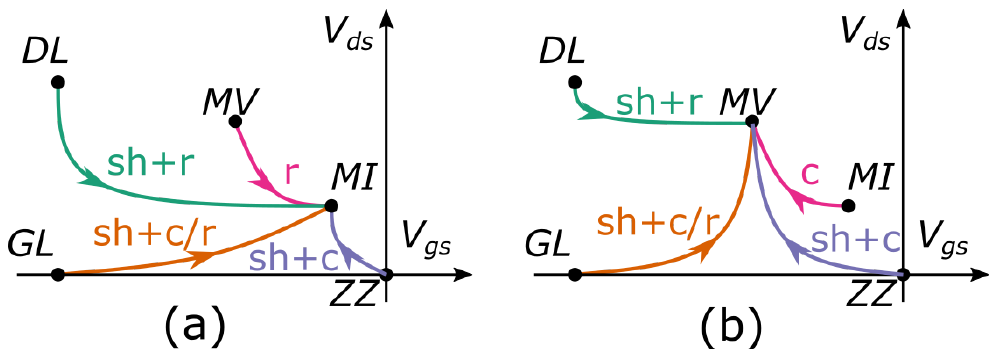
Figure 7. Graphical representation depicting all the relevant trapping/de-trapping transitions on the V GS − V DS plane from the ZZ , GL , DL points to the MI ( a ) and MV points ( b ). The involved processes are highlighted on the transitions: self-heating ( sh ), charge capture ( c ), and release ( r ). Each transition displays a different combination of capture/release and thermal tran- sients, which is often overlooked in typical gate/drain-lag characterizations. For example, the charge release and self-heating transient from DL in Figure 8 displays a regular increase of the current due to de-trapping, but also a clearly identifiable current decrease at the ∼ 1 ms mark, likely linked to self-heating.